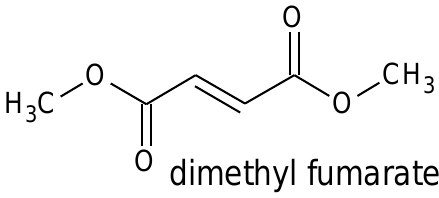
Figure 6. Chemical structure of dimethyl fumarate. DMF was approved by the FDA and EMA in 2014 as a medication to treat relapsing forms of multiple sclerosis (MS) at 240 mg 2–3 times per day [87,88]. Multiple